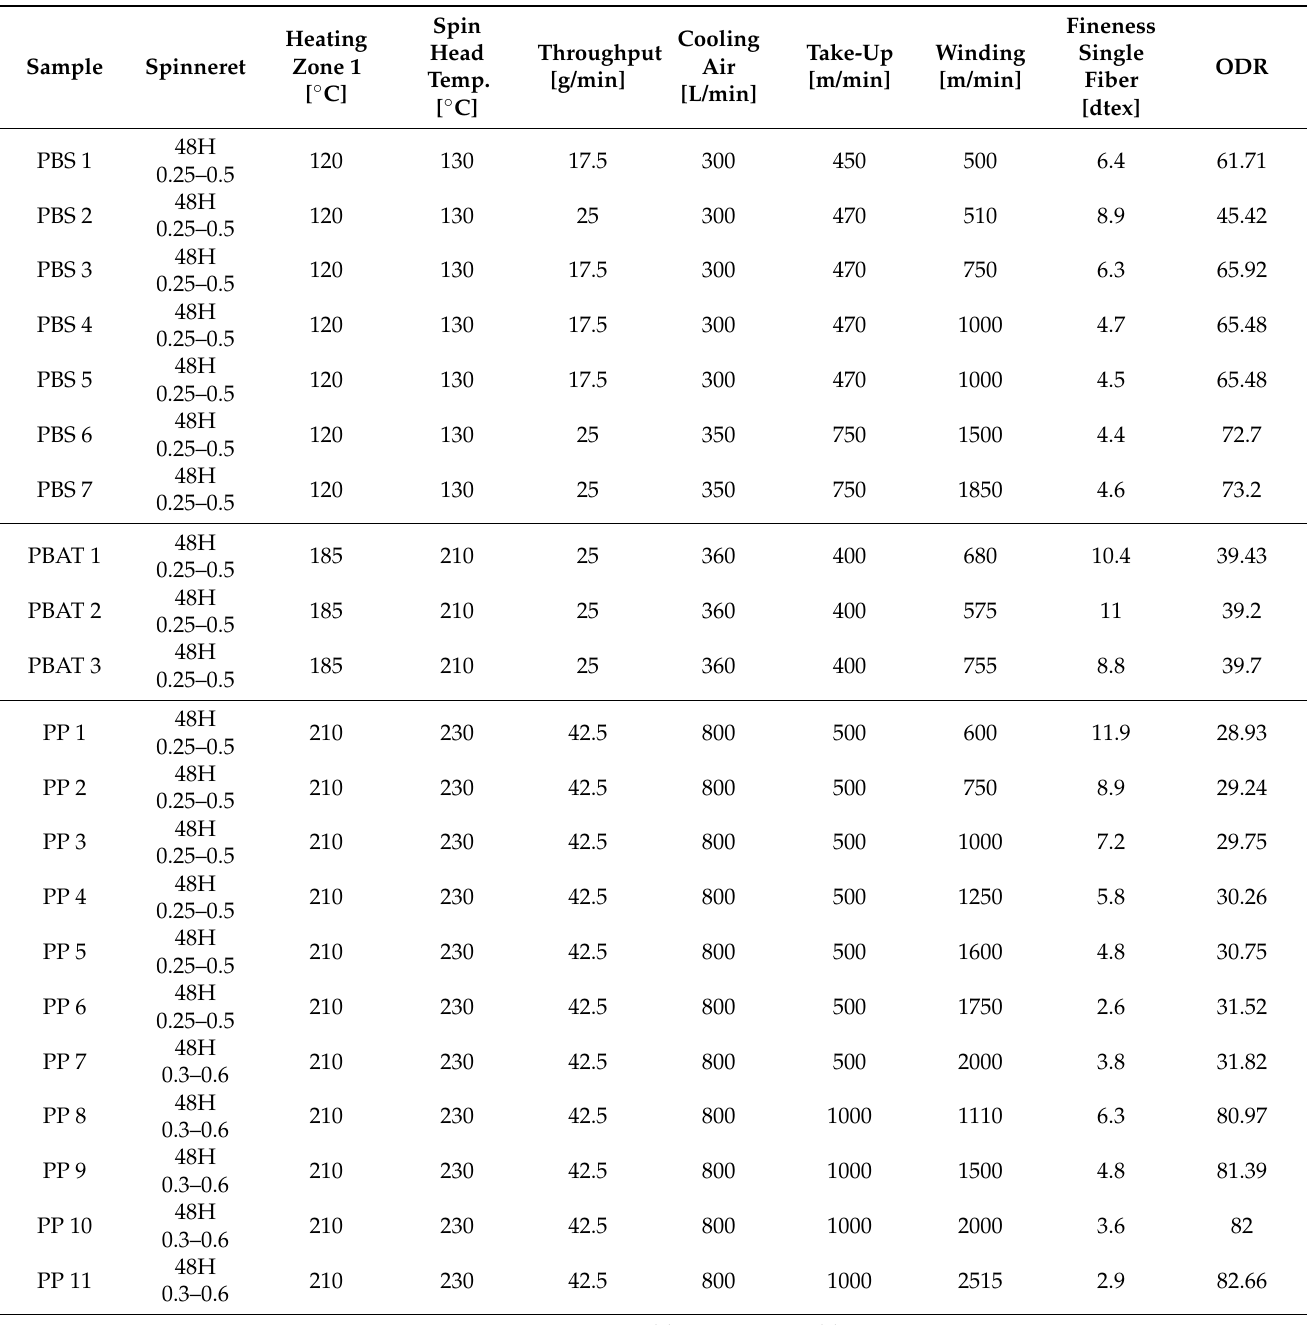
Table 2. FET-100 machine